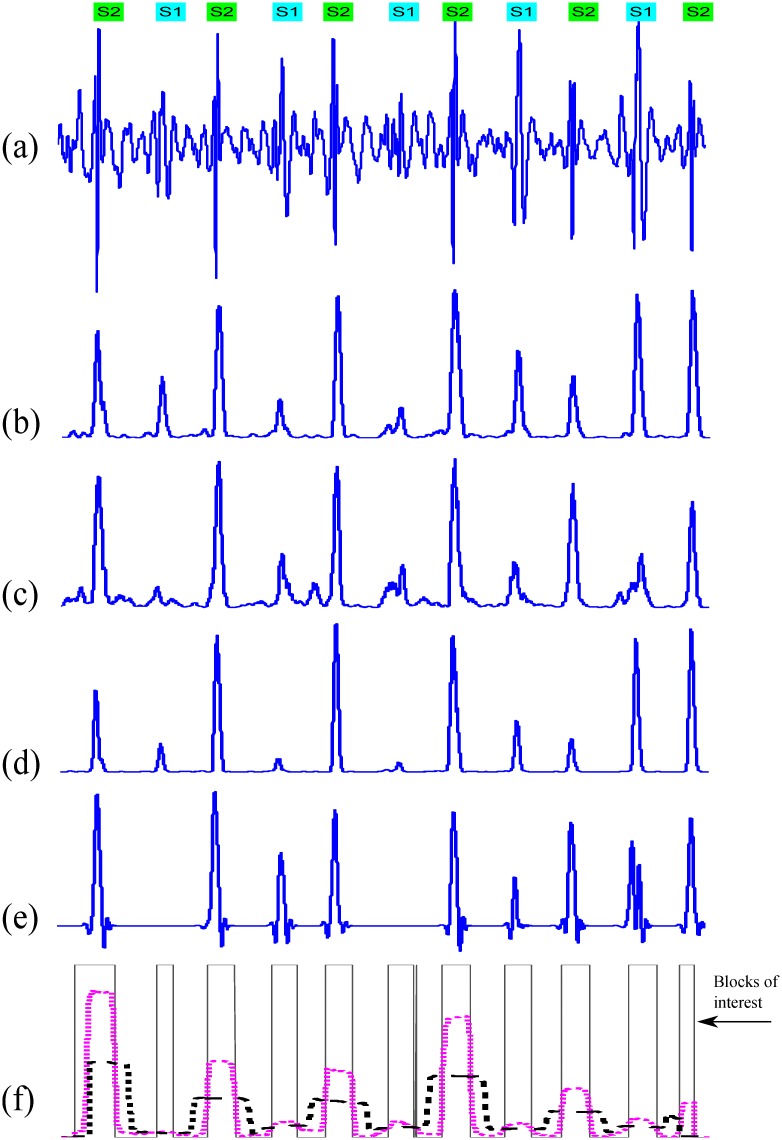
Features output.(a) Original heart sound signal from a subject with mean pulmonary arterial pressure of 20 mmHg (b) second-order Shannon energy of D
5 wavelet in Method I (c) second-order Shannon energy of D
6 wavelet in Method II (d) third-order Shannon energy in Method III (e) wavelet approximation A
6 in Method IV (f) generating blocks of interest in Method V.